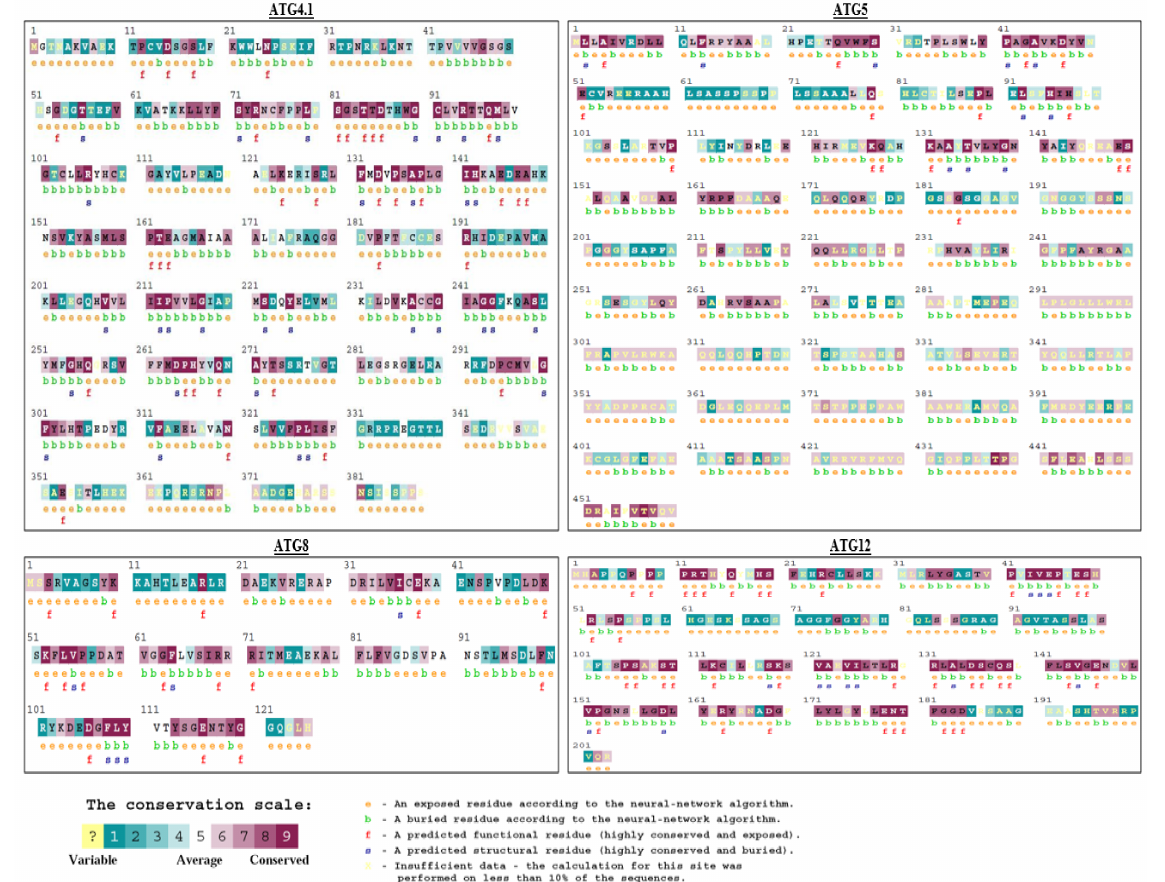
Figure 4. Sequential Conservation analysis of ATG proteins using ConSurf web server A. ATG12, B. ATG8, C. ATG4.1, D.